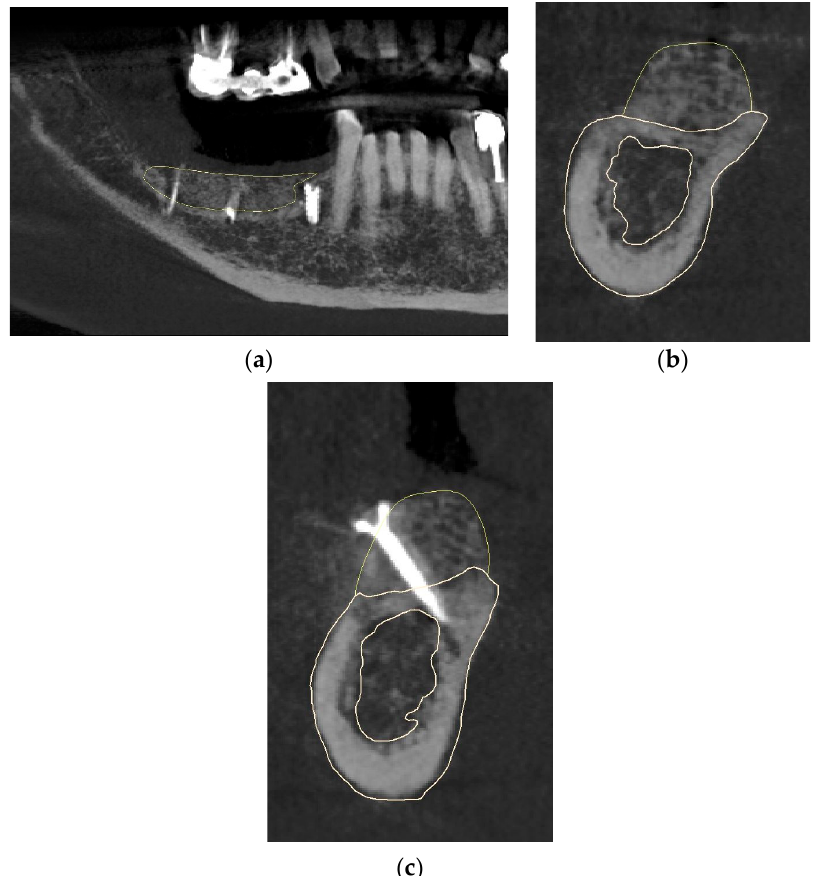
Figure 11. ( a – c ) CBCT analyses showing the results vs. design (yellow lines).